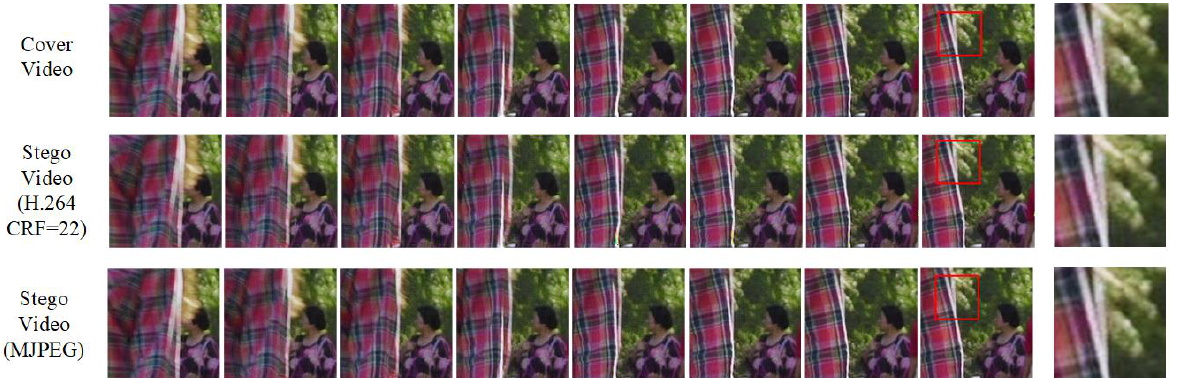
Figure 9. Cover video and stego videos (H.264 CRF = 22 and MJPEG mean the stego video will be compressed by H.264 with CRF = 22 and MJPEG in the noise layer respectively).